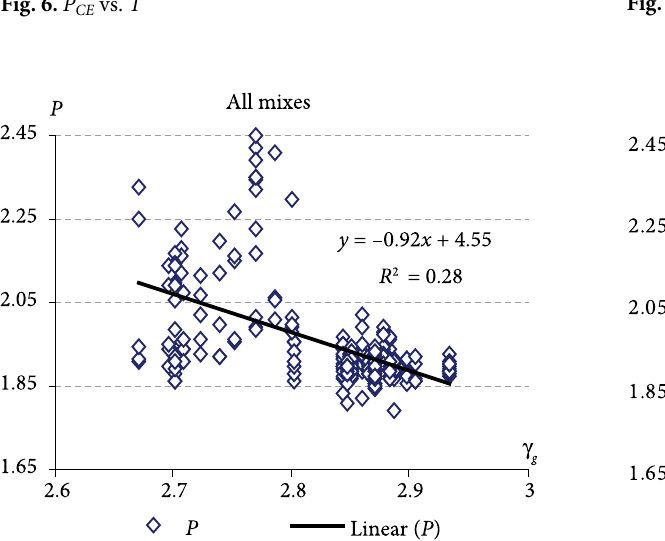
Fig. 8. P CE vs. aggregate apparent specific gravity